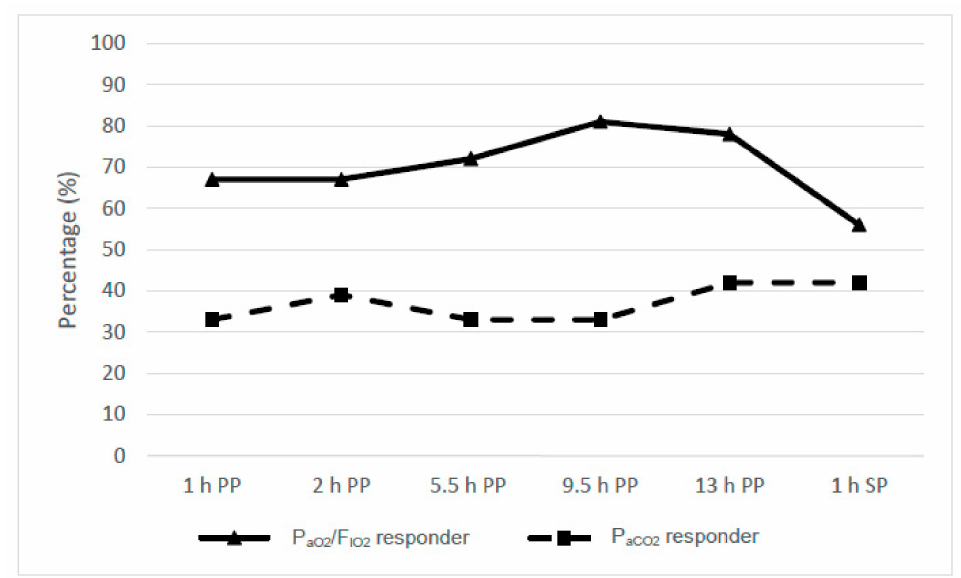
Figure 1. Partial pressure of oxygen in arterial blood/fractional inspired oxygen concentration (P aO2 /F IO2 ) responder ( ≥ 15% improvement in P aO2 /F IO2 ) and P aCO2 responder ( ≥ 2% improvement in P aCO2 ) during the prone (PP) and supine (SP) positions. h,